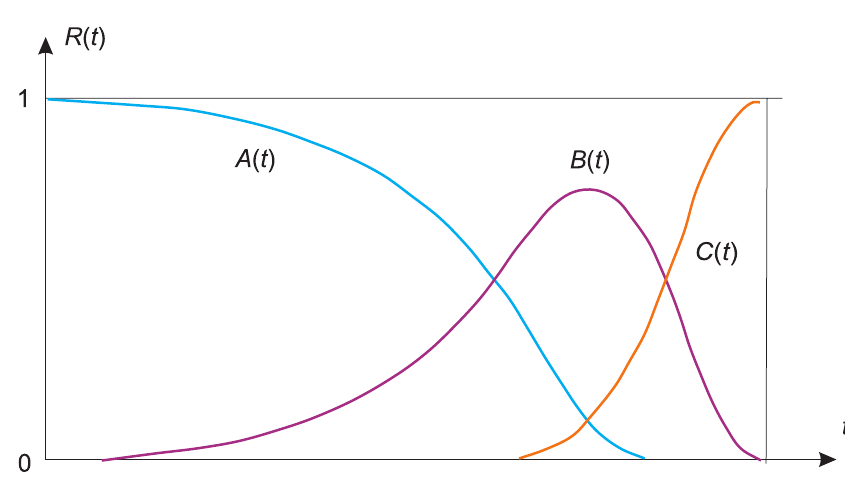
Fig. 2. The qualitative model of innovations culture